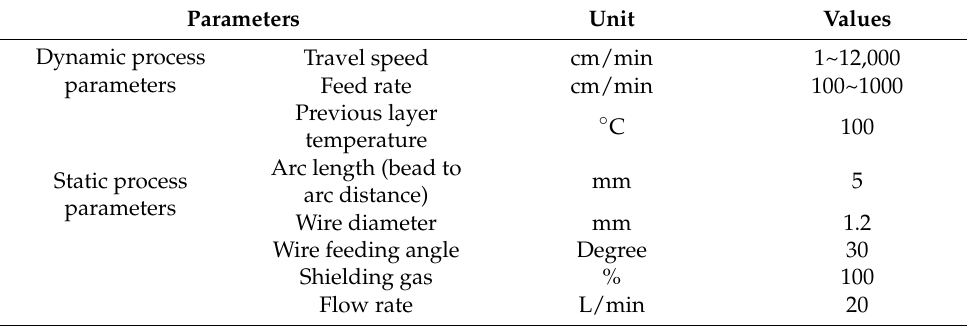
Table 1. WAAM process parameters.